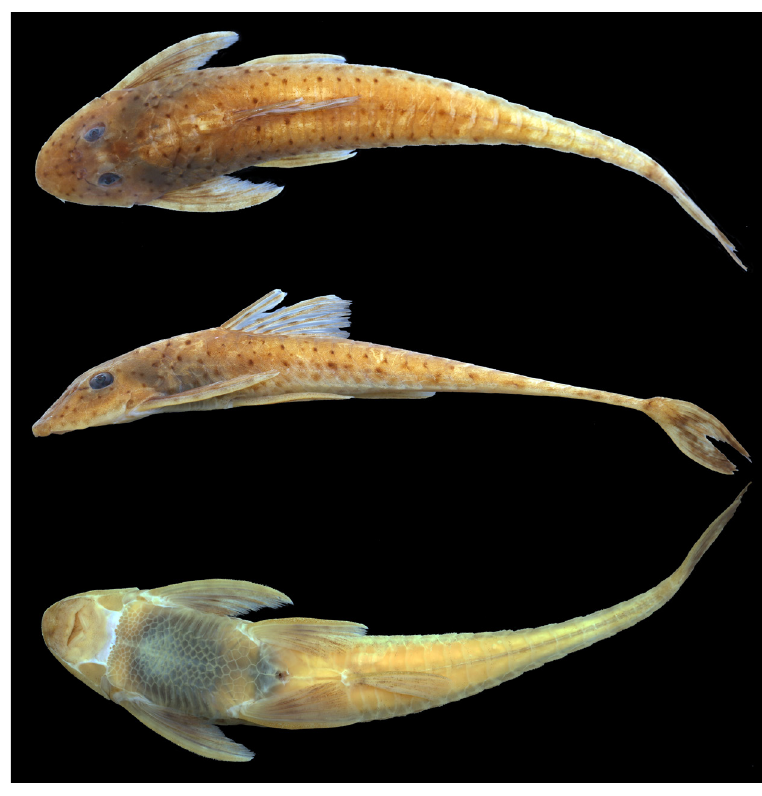
FIGURE 2 | Cteniloricaria napova , MPEG 34190, 117.4 mm SL, Brazil, Pará State, Óbidos municipality, unnamed creek tributary to Cuminapanema River, Curuá River basin (approx. 0°57’S